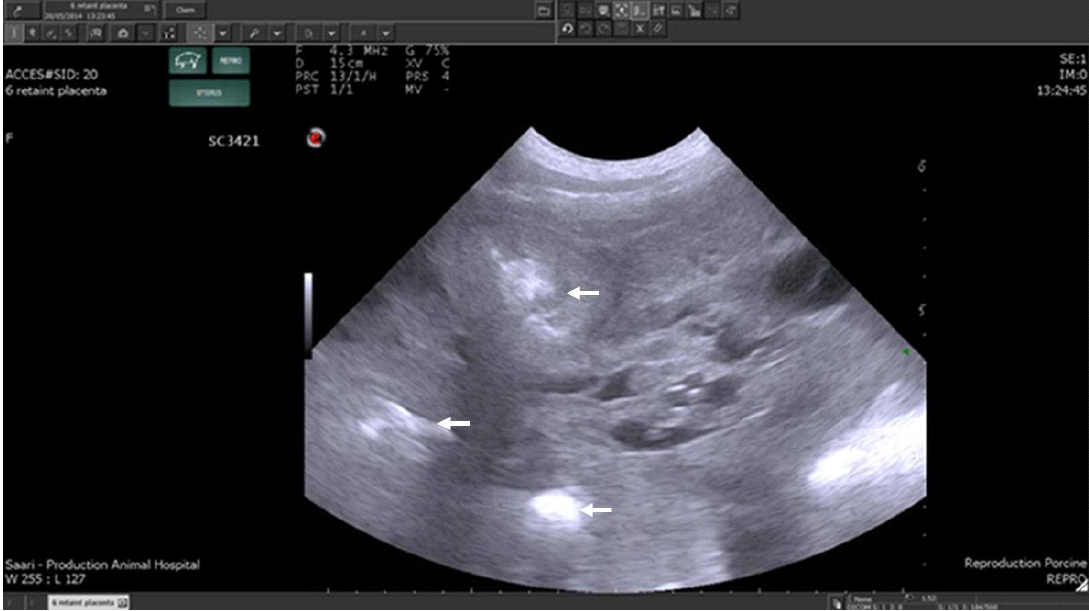
Figure 2. Transabdominal ultrasonographic image of cross sections of uterine horns of a sow on post-partum day 3 with retained placentae, as indicated by intrauterine hyperechogenic material (arrows). Scale bar on right margin in 1.0 cm steps [30].